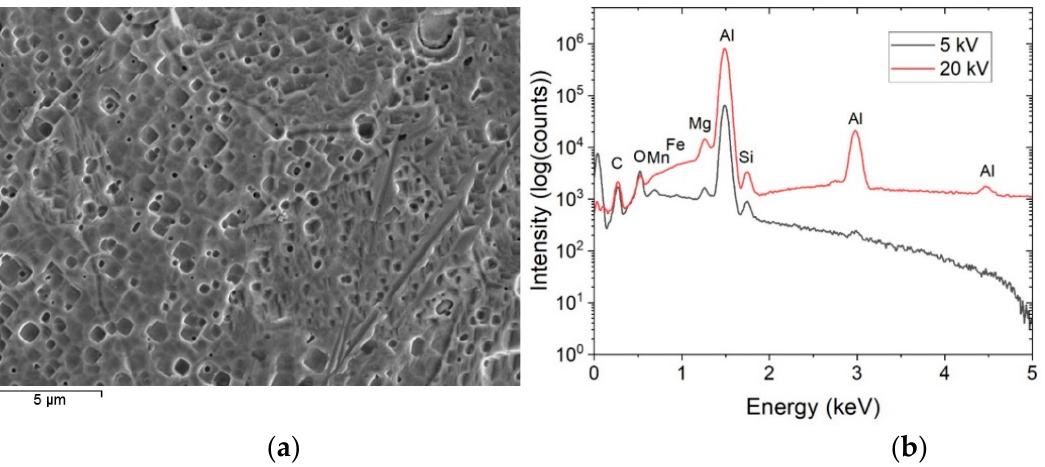
Figure 4. SEM analysis of unpolished aluminium sample after fluoride-based solution treatment: ( a ) ×5k magnification image; ( b ) EDS analysis of the sample by using a 5 kV and 20 kV acceleration potential at a magnification of × 100.